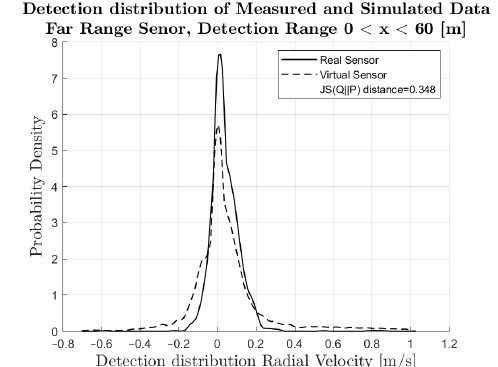
Figure 12. Evaluation of the detections in the range of 0 to 60 m of the far-range radar sensor and sensor model: PDF of the relative velocity in the x -direction from the reference velocity of the real sensor and sensor